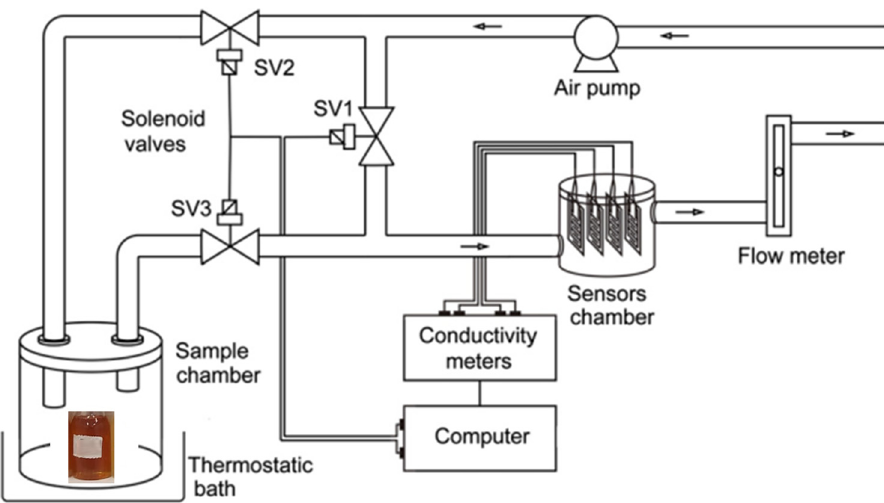
Figure 1. Schematic representation of the